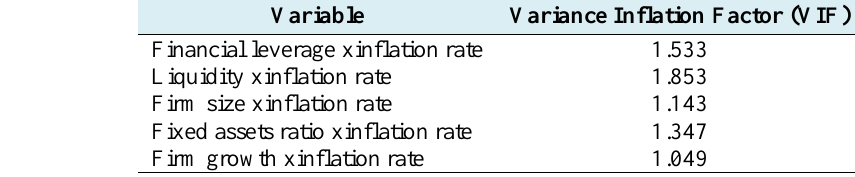
Table 11. The results of testing the absence of multicollinearity among explanatory variables in model (2) in the BSE